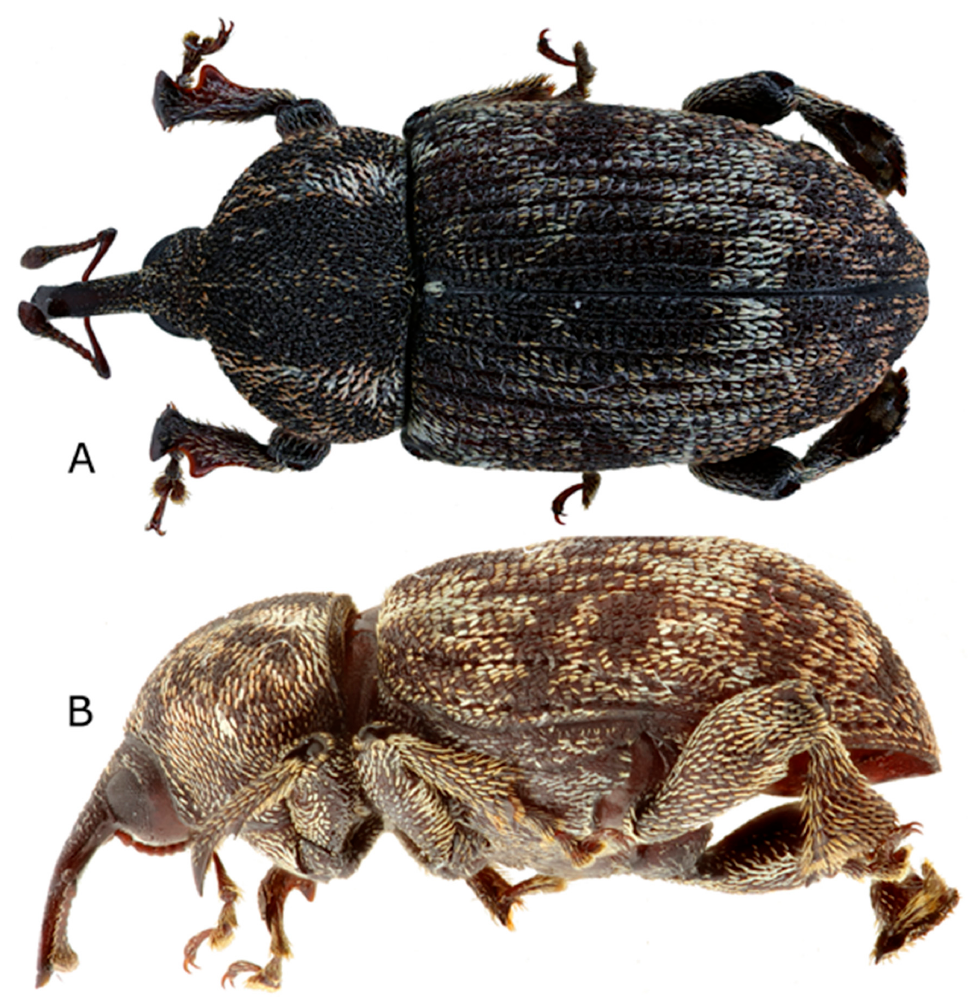
Figure 14. Sclerocardius kuscheli sp.nov. habitus: ( A ) dorsal, and ( B ) lateral.